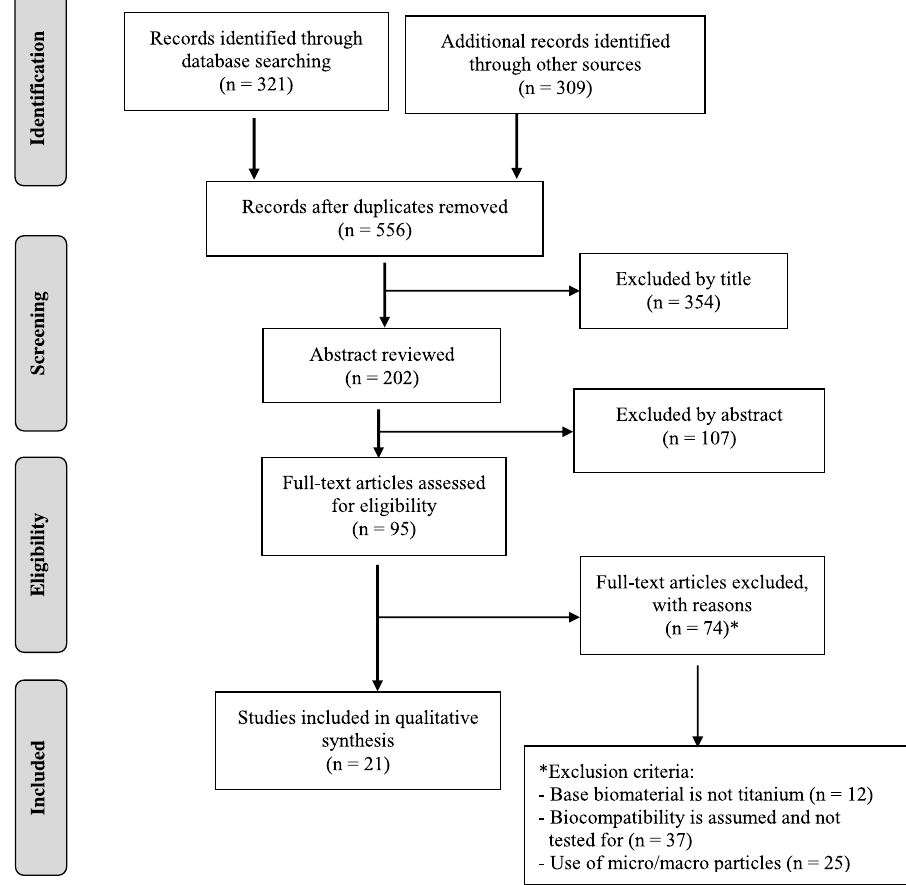
Fig. 1. The PRISMA fl ow chart for search strategy and selection criteria for eligible